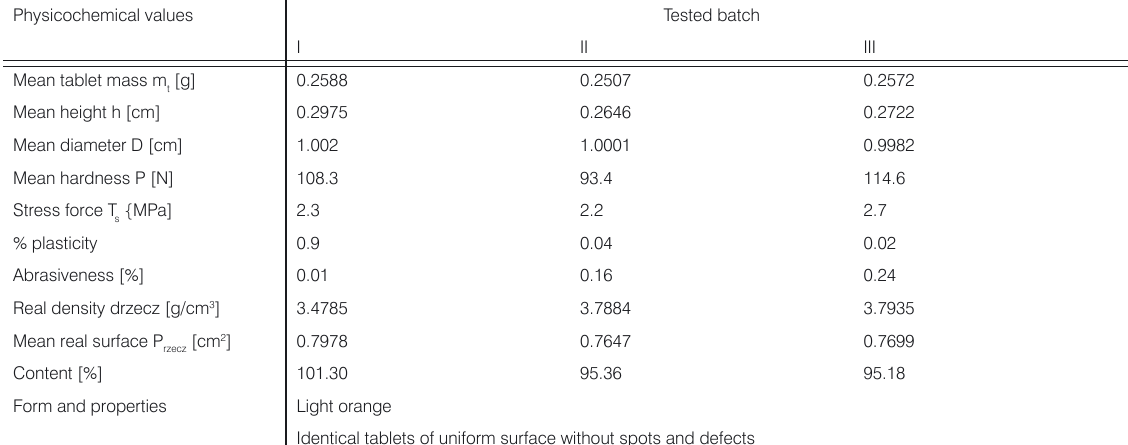
Table 1. Basic physicochemical values of the produced tablets.